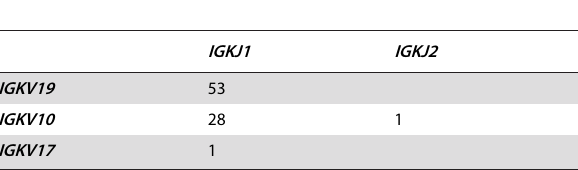
Table 4. Expressed combinations of IGKV and IGKJ gene segments in bovine fetal bone marrow and ileum.